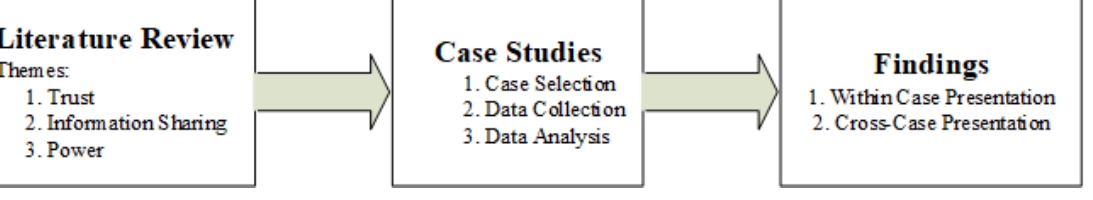
Figure 1. Research method